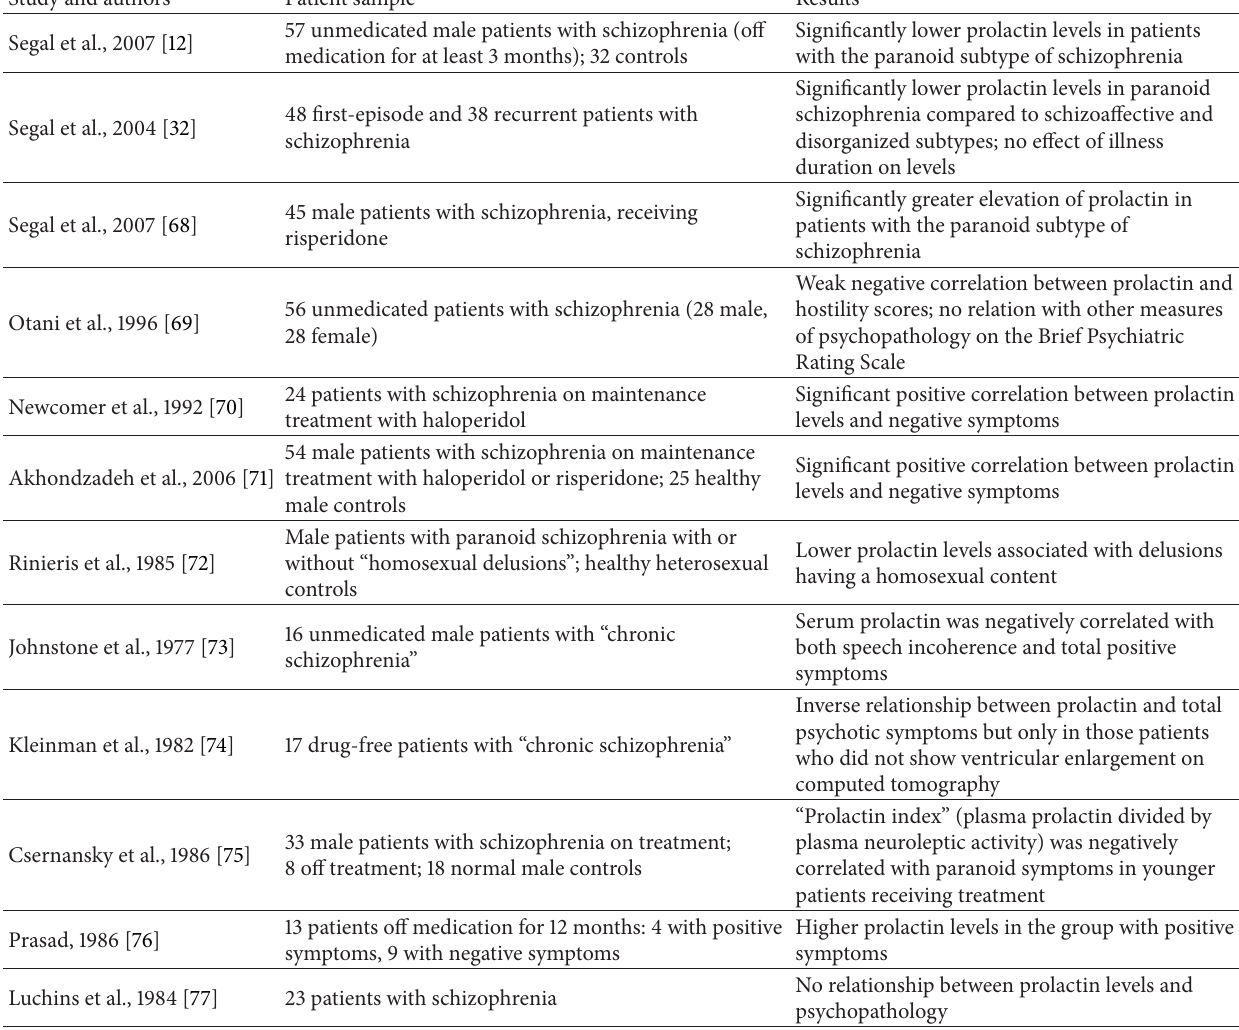
Table 2: Studies examining the relationship between symptom profile and prolactin in